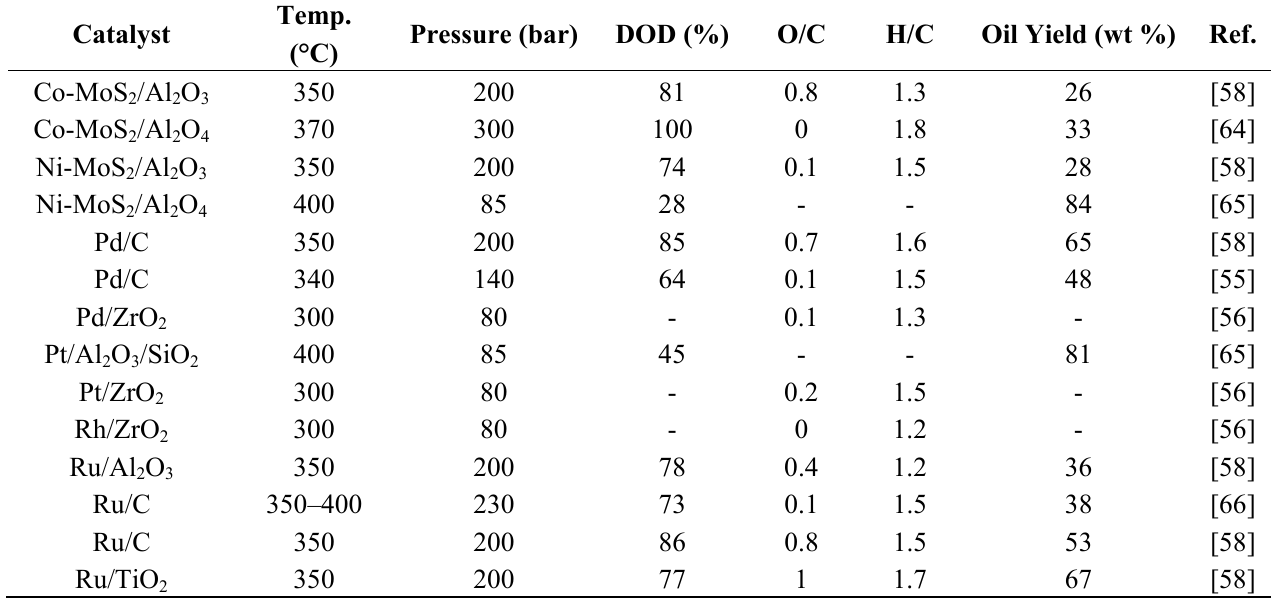
Table 2. Summary of catalysts investigated for